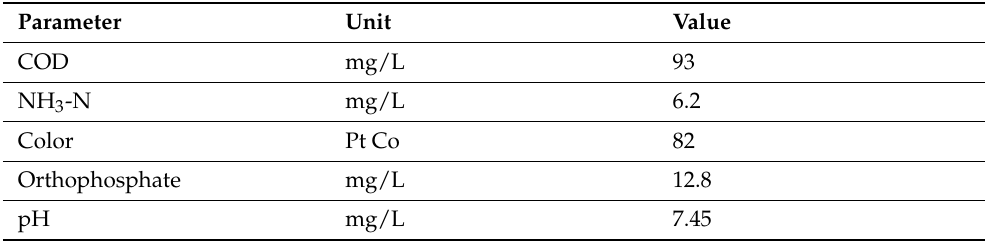
Table 1. The characteristics of collected